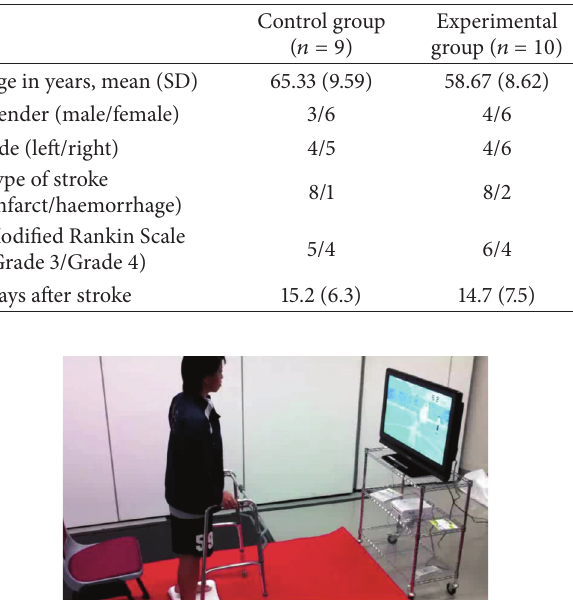
Figure 1: Subject standing on the Nintendo Wii-Fit Balance Board attached to a TV